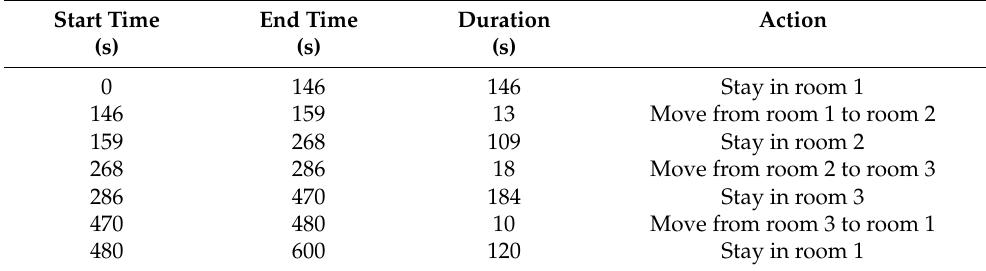
Table 3. The human tracking